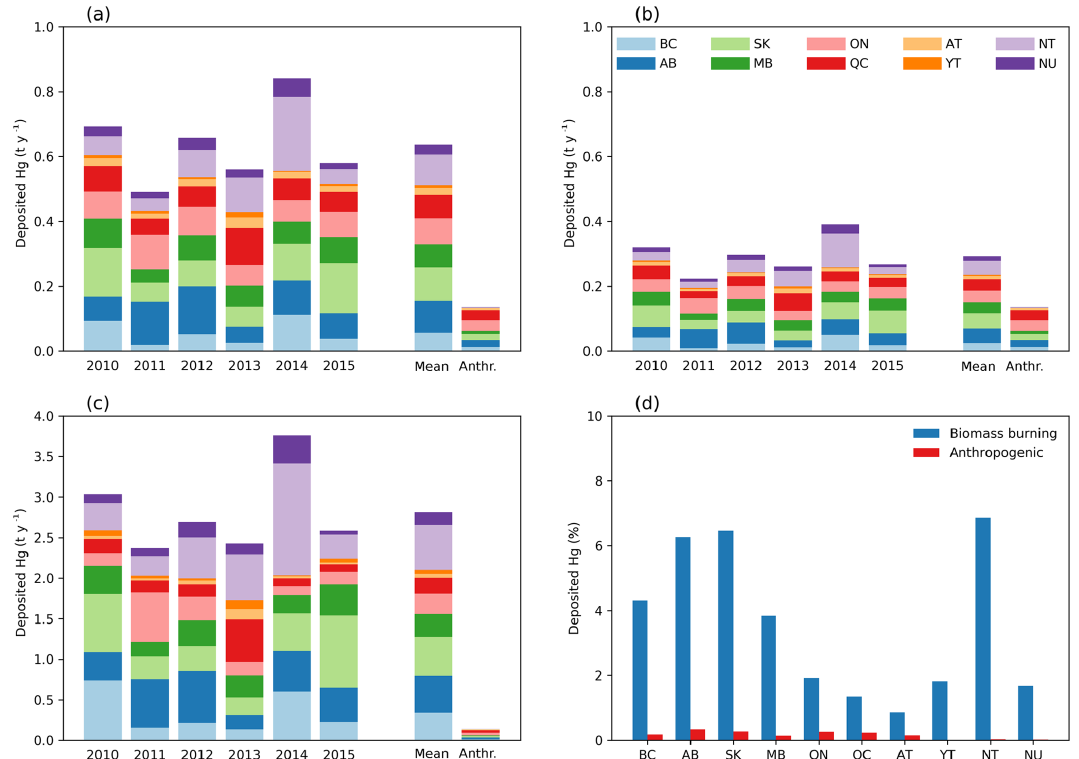
Figure 13. Total atmospheric mercury deposition (t year − 1 ) by province/territory for the burning seasons (May–September) of 2010–2015 from (a) prior, (b) posterior and (c) prior emissions with PBM mercury emissions from Canadian biomass burning. Also shown are the mean of the 6-year time period and the mean of the deposition from Canadian anthropogenic emissions for the burning season. (d) Biomass burning and anthropogenic deposition contributions relative to the total Hg deposition in respective provinces/territories during biomass burning season for prior with PBM biomass burning emissions scenario. Provincial/territorial abbreviations are given in the caption of Fig. 1. As in Fig. 6, we have grouped the Atlantic provinces into one group,